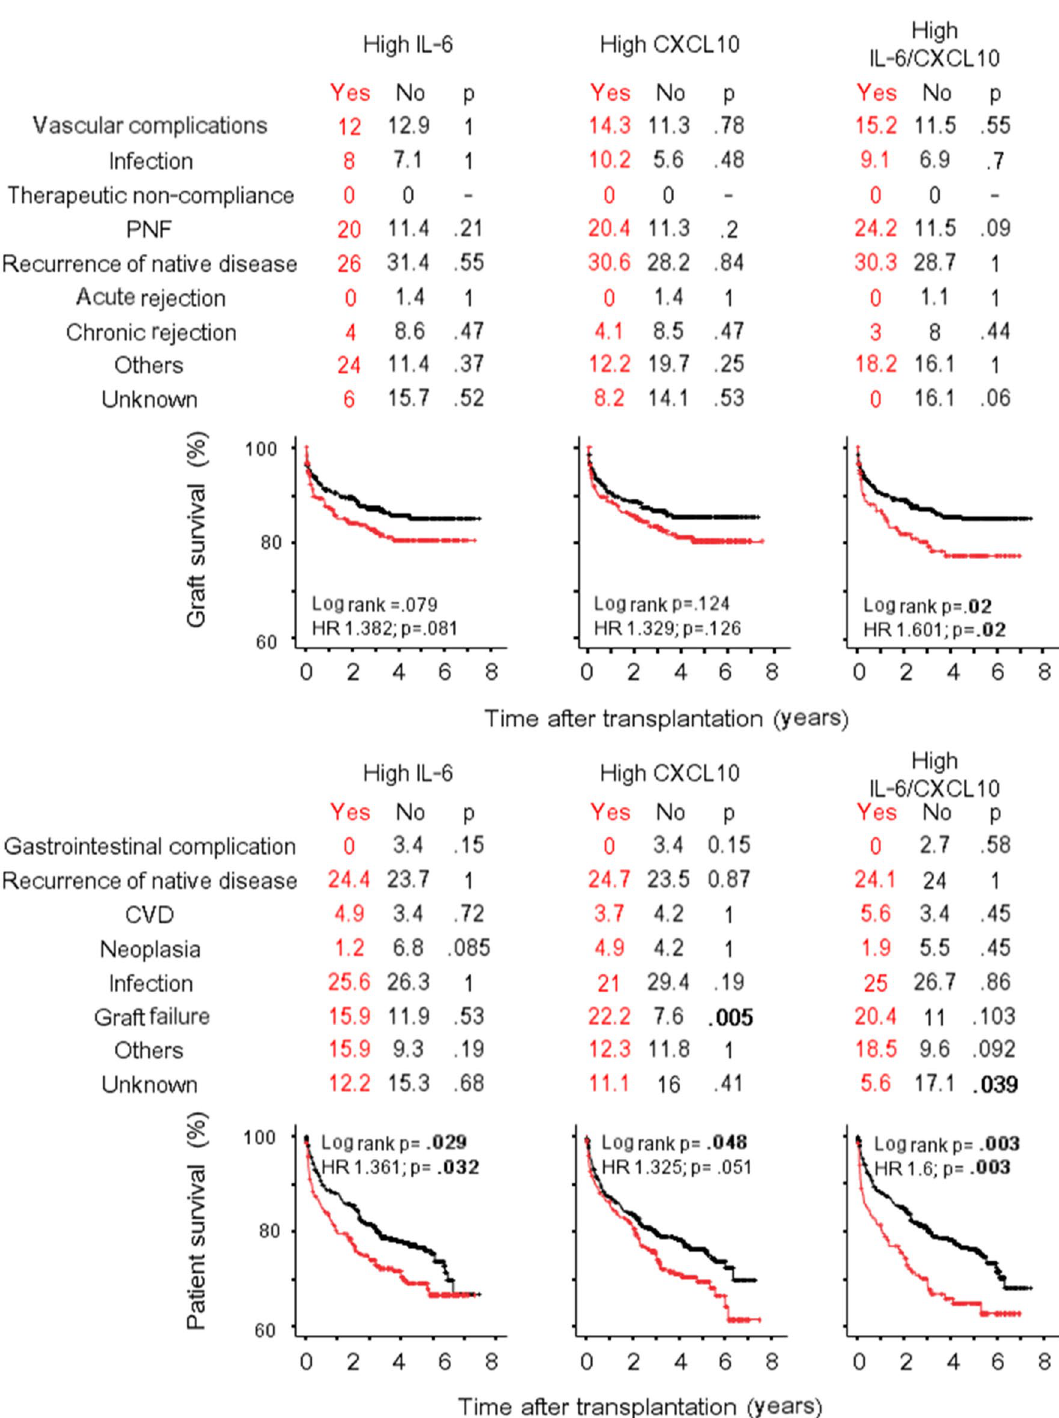
Figure 3. Graft and recipient survival after liver transplantation. Causes of graft failure (%), causes of recipient death (%) and Kaplan–Meier graft and recipient survival curves after liver transplant are represented according to high IL-6 and high CXCL10 categories. PNF primary non function, CVD cardiovascular